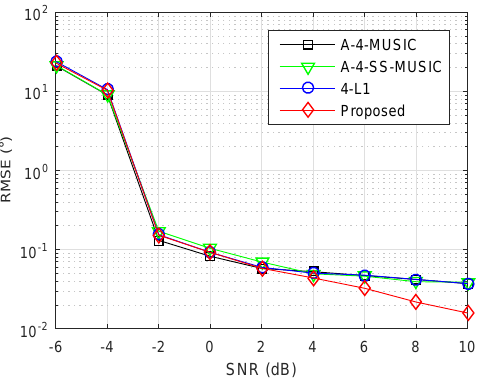
Figure 4. RMSE performance of four methods versus SNR, S = { 1,2,4,11,25 } × d , K = 2, r = 0.1 ◦ , L =